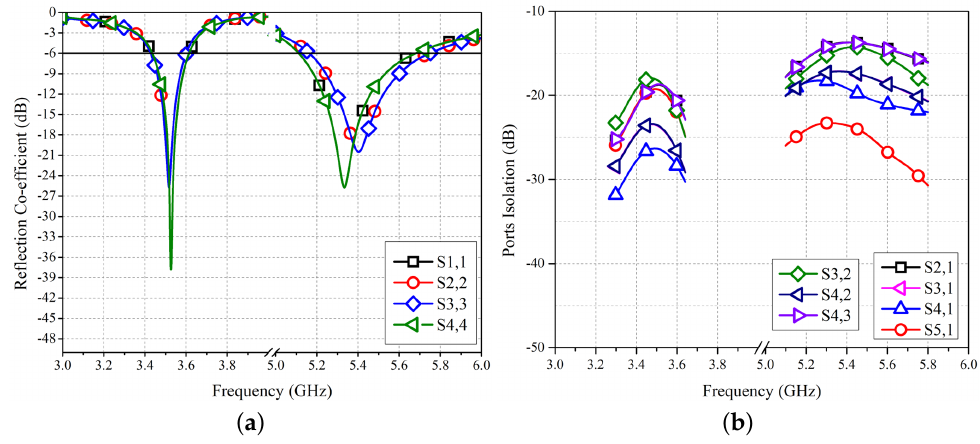
Figure 5. Simulated S-parameters of the MIMO antenna system. ( a ) Reflection coefficient; ( b ) ports isolation.